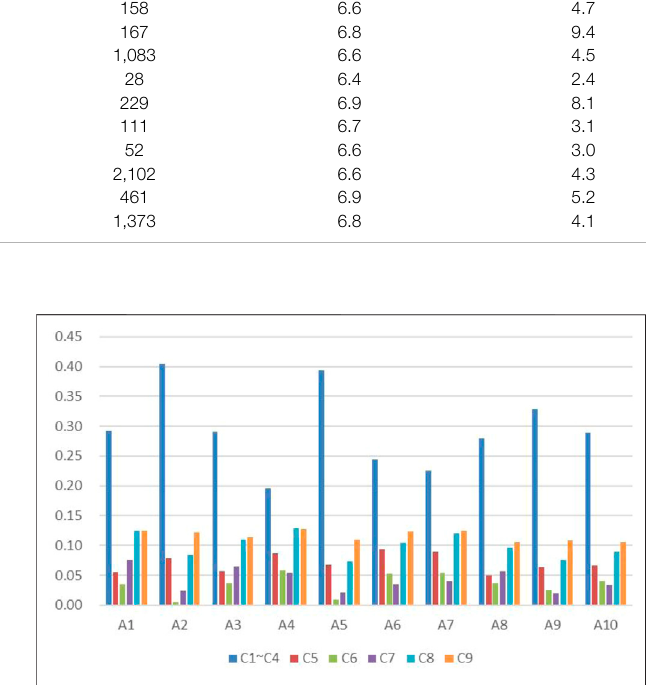
FIGURE 7 | Relevant weight of each regional evaluation